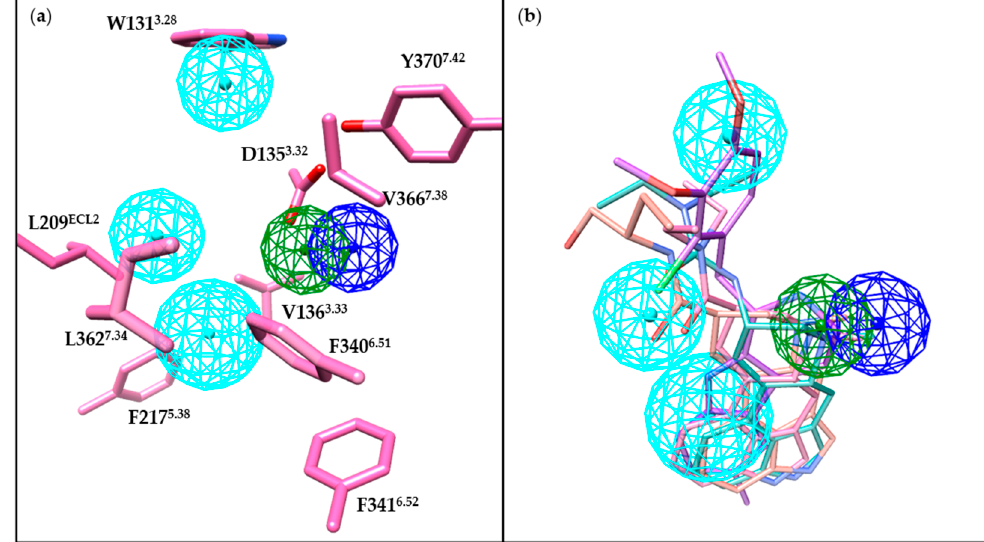
Figure 11. Key pharmacophore features of the 5-HT 2B R. Positive electrostatic, hydrogen bond donor and hydrophobic pharmacophore features are colored in blue, green, and cyan, respectively. Pharmacophore features were generated based on the 5-HT 2B R crystal structure (PDB ID: 5TVN) using the CavityPlus web server [152]. ( a ) Association of 5-HT 2B R residues and pharmacophore features. Residues close the pharmacophore and contributing to the protein–ligand interactions are shown in hot pink sticks. ( b ) Association of co-crystal ligands and pharmacophore features. LSD (PDB ID: 5TVN), lisuride (PDB ID: 6DRX), methylergometrine (PDB ID: 6DRY), and LY266097 (PDB ID: 6DS0) are shown as hot pink, light sea green, salmon, and purple stick, respectively. These ligands are aligned based on residues in the binding pocket. Molecular images were generated using the UCSF Chimera software [115].